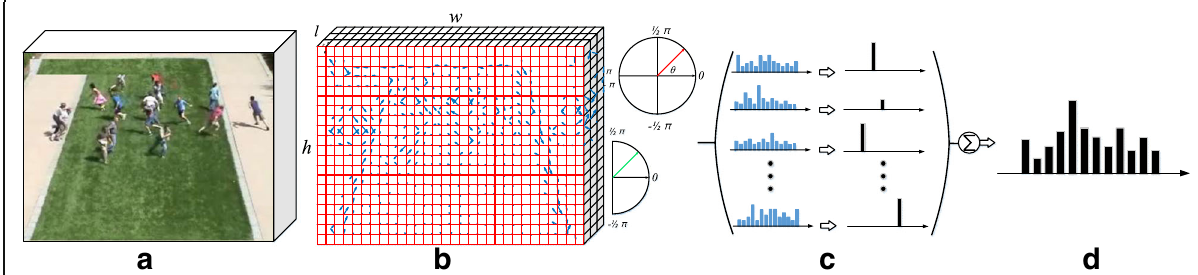
Fig. 2 Illustration of the processes for constructing a HOCG descriptor for an event. a A video clip (an event), ( b ) directions of contextual gradients of sub-regions, ( c ) quantizing descriptors of sub-regions, and ( d ) HOCG